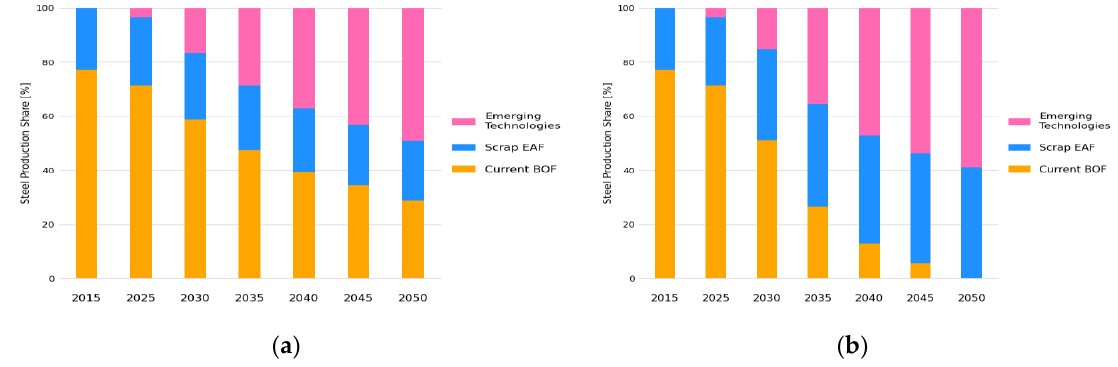
Figure 11. Australia’s steel production technology mix over time for different scenarios: ( a ) LME; ( b ) P1.5 °C.